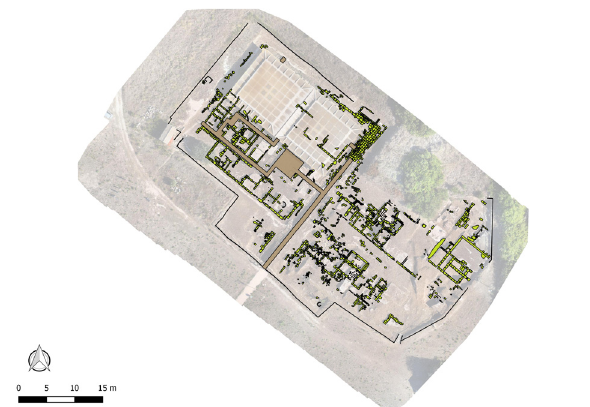
Figure 18. Vectorisation of the Insulae ortho-image.